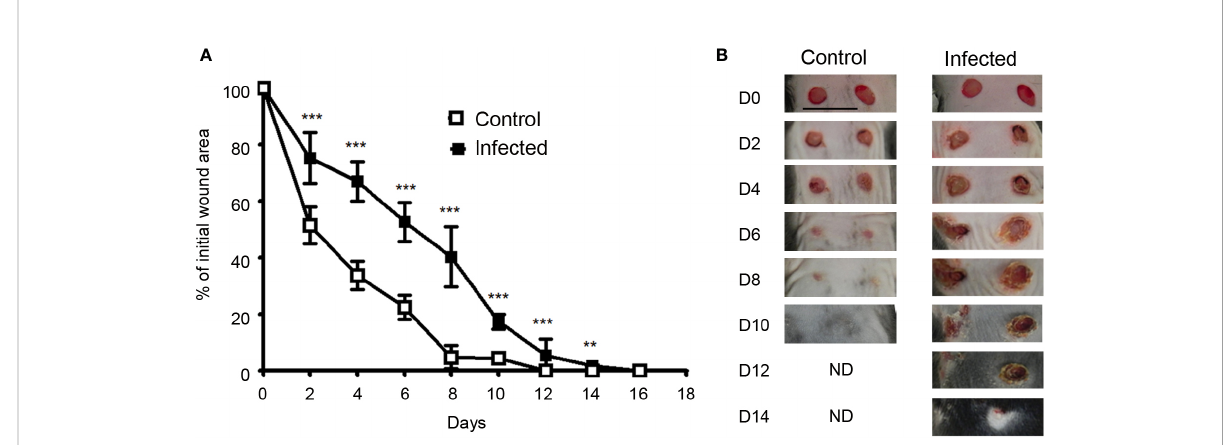
FIGURE 1 Wound closure is delayed in infected skin excisional wounds. (A) Time course of wound closure expressed as the percentage of initial wound area at each time point, in the control wound ( □ ) or wound infected with a mixture of S. aureus and P. aeruginosa ( ■ ). The data are expressed as the mean +/- SEM of 5 independent experiments, with at least 4 mice/group; ** p <0.01, *** p <0.001. (B) Representative photographs of the control and infected wounds at days 0, 2, 4, 6, 8, 10, 12 and 14 after